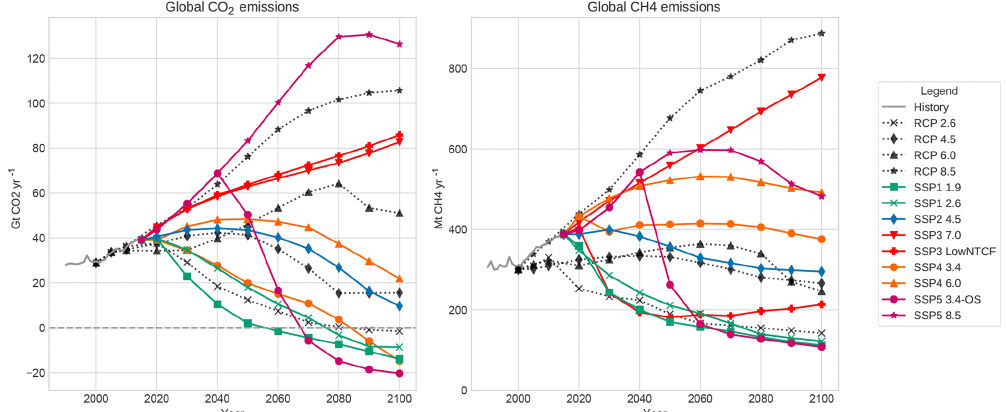
Figure 3. Trajectories of CO 2 and CH 4 , primary contributors to GHG emissions, including both historical emissions, emissions analyzed for the RCPs, and all nine scenarios covered in this